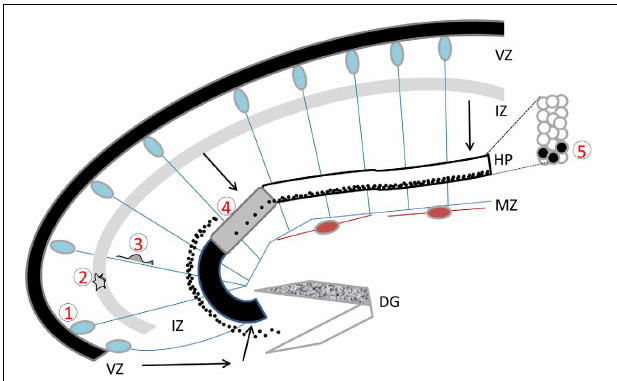
FIGURE 1 | The developing hippocampus. Radial glial cells are represented with their somata in the ventricular zone (VZ) and long basal processes extending up to the marginal zone (MZ). These processes serve as guides for migration. Cajal Retzius cells are schematized in brown. Migration pathways across the intermediate zone (IZ) are indicated by arrows. The hippocampal plate (HP) is shown in white, gray, and black to indicate the CA1, CA2, and CA3 fields respectively. The dentate gyrus (DG) is indicated as a V-shaped structure, at this stage the inferior blade (shown in white) is not completely formed, whereas the superior blade (shown in mottled gray) is taking shape. A BrdU injection at E18 in the rat, with sacrifice 4 days later reveals BrdU-labeled cells as schematized by the black dots: cells born at E18 have already reached the CA1 developing pyramidal cell layer, whereas CA3 cells are still found in the IZ, requiring another full day to cross the CA3 pyramidal cell layer. An inset shows the organization of somata in the pyramidal cell layer. Five successive steps of development are indicated, (1) cell proliferation and neurogenesis in the VZ; (2) a multipolar phase above the VZ; (3) a bipolar phase of migration through the IZ; (4) insertion in the hippocampal plate; (5) settling in the appropriate layer. Schema based on data shown in Altman and Bayer (1990b), Figure